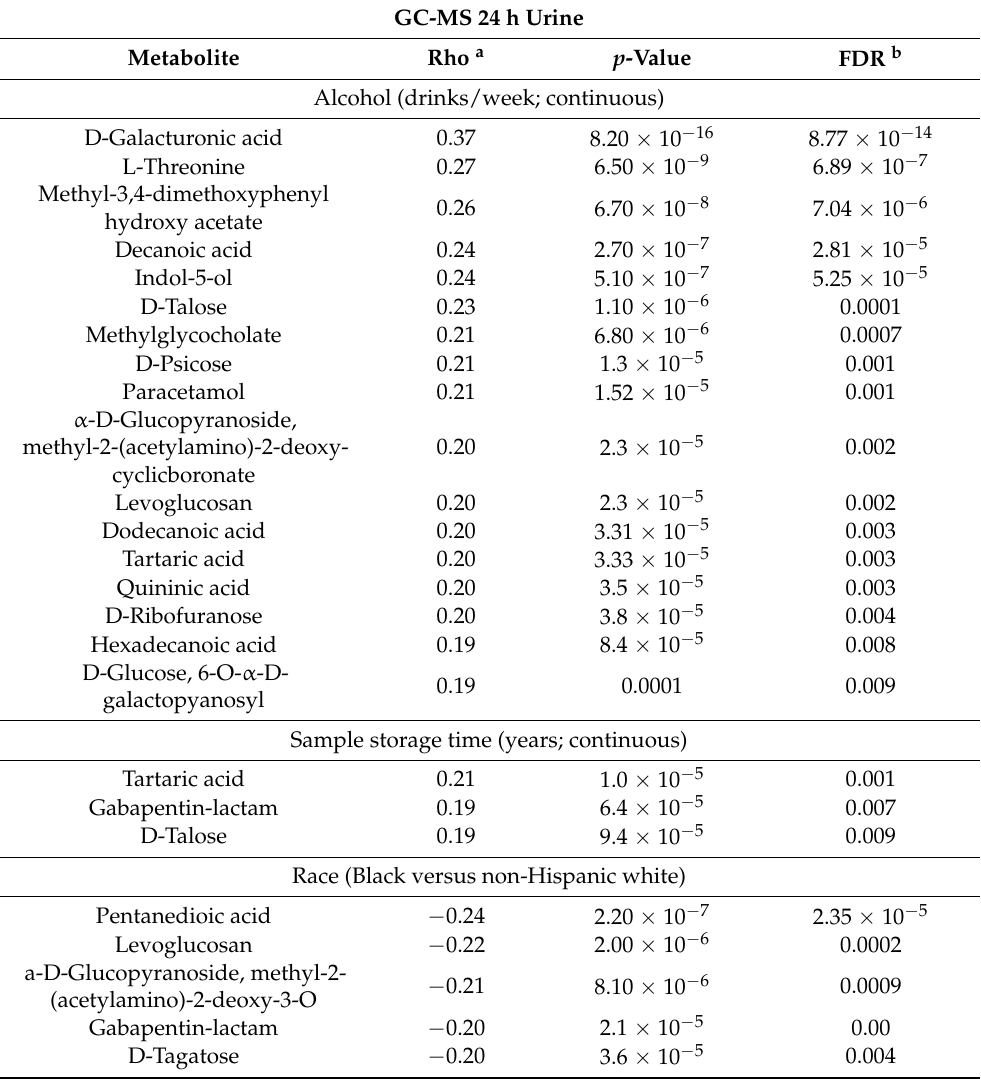
Table 5. Variables correlated with metabolites at FDR < 0.01 by GC-MS, descending in level of statistical significance within each